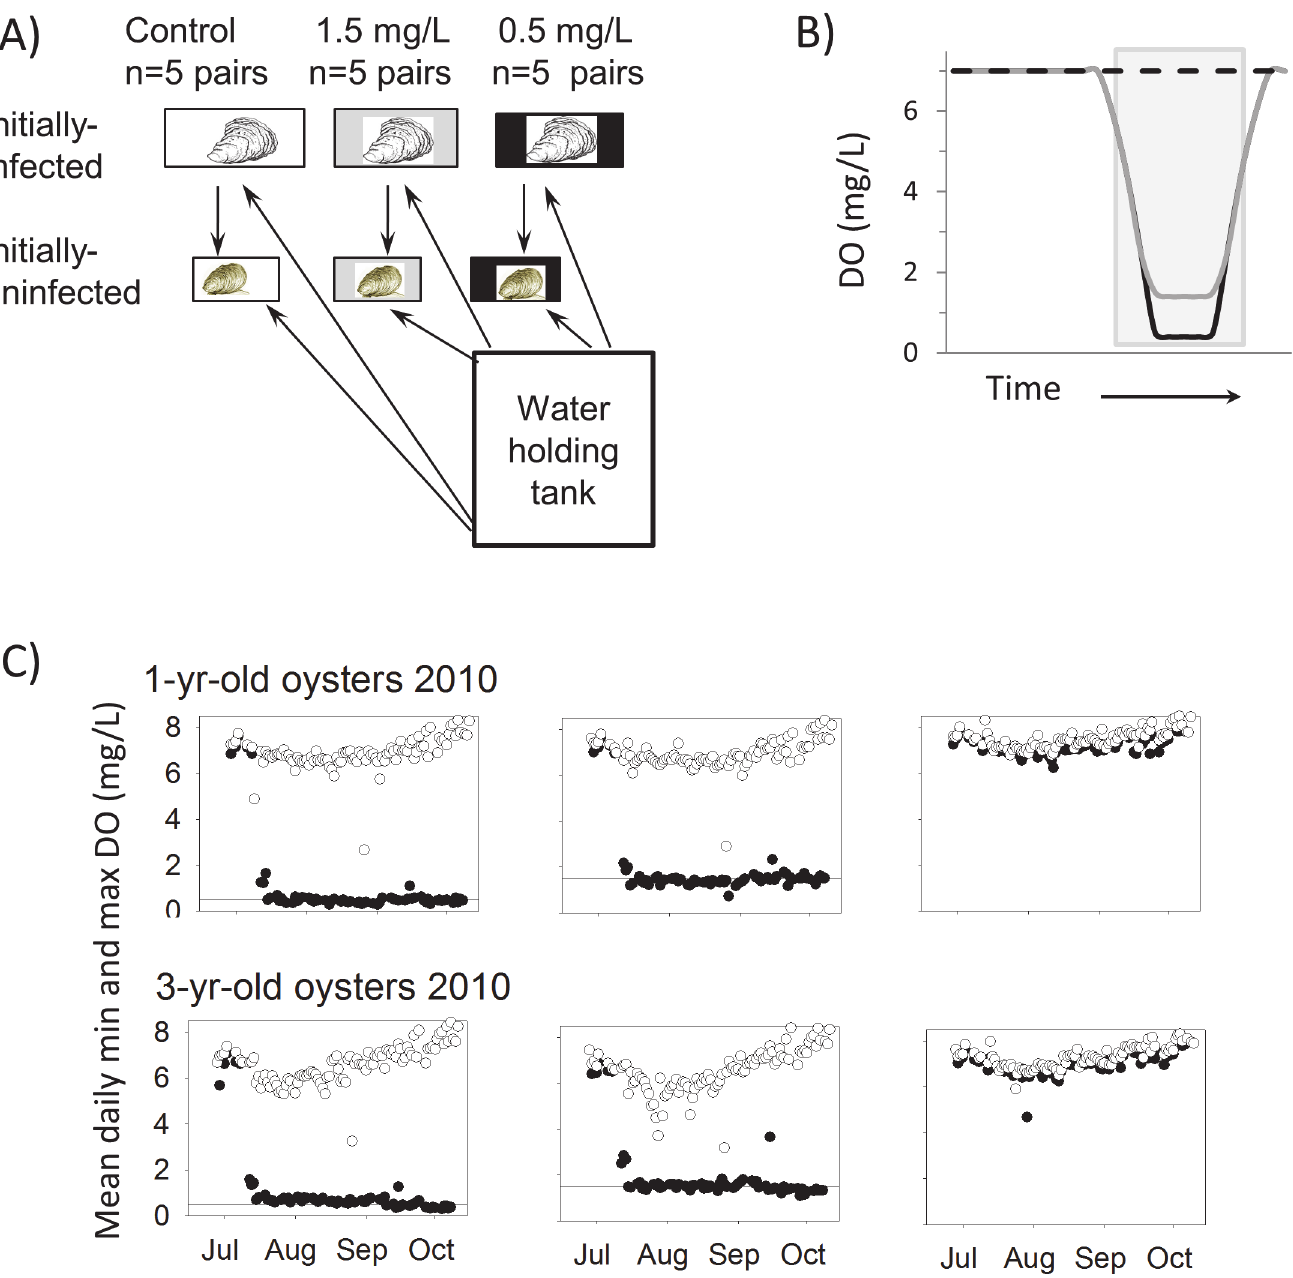
Fig 3. Laboratory experiment. (A) Experimental treatments. Arrows indicate direction of water flow. (B) Idealized dissolved oxygen cycle in experiments. Dashed black line = high DO control treatment; grey line = 1.5 mg l -1 treatment; black solid line = 0.5 mg l -1 treatment. The grey shaded box indicates the dark period. (C) Daily minimum (black circles) and maximum (open circles) dissolved oxygen concentrations measured in experiment tanks for each treatment in 2010. Horizontal lines indicate target DO concentrations in the 2 diel-cycling hypoxia